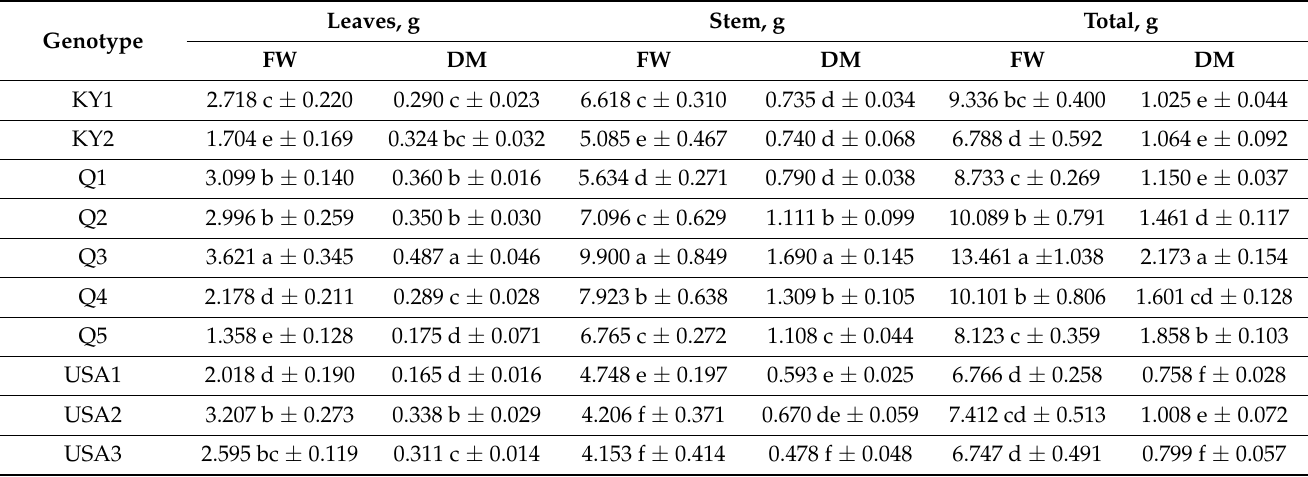
Table 3. Fresh weight (FW) and dry matter (DM) of the lower parts of the quinoa